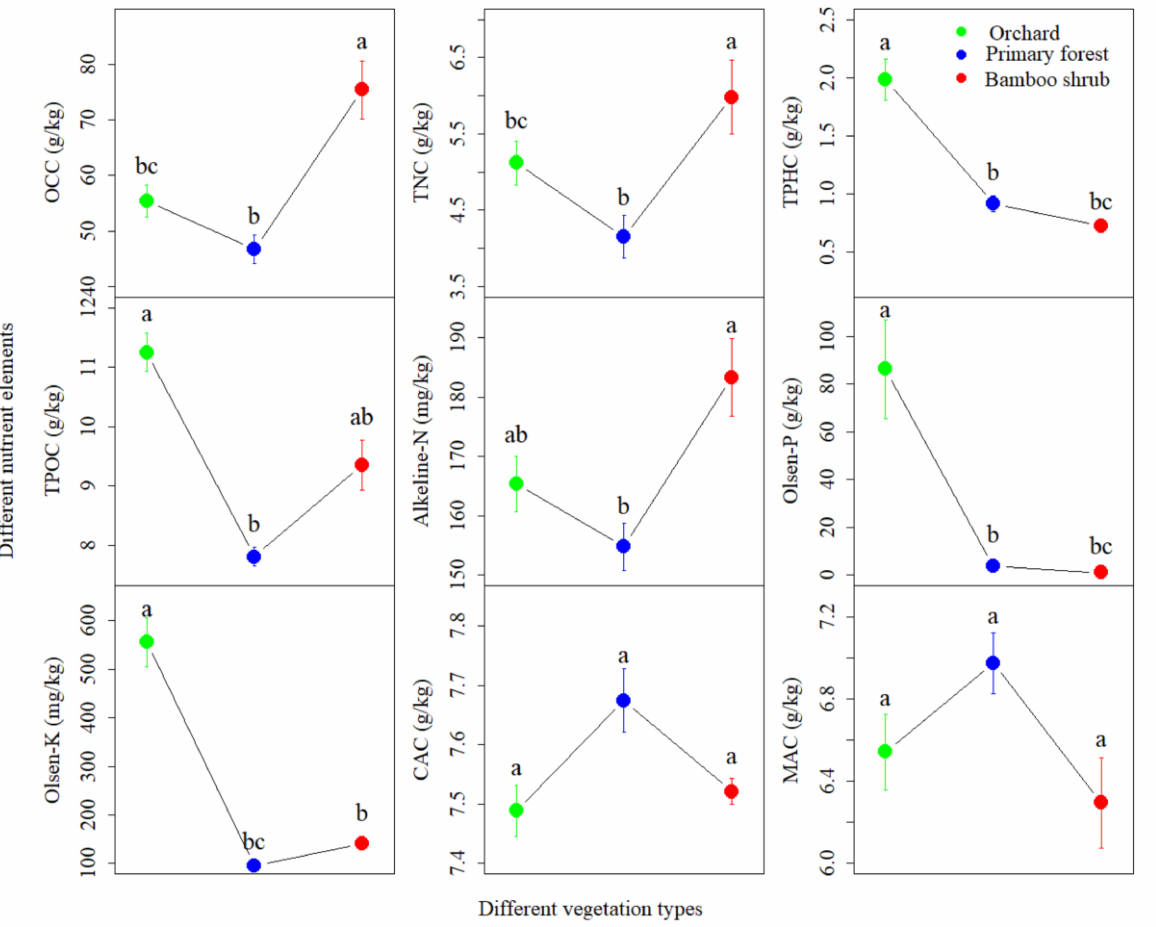
Figure 3. Difference analysis of soil physiochemical properties in each vegetation type (mean ± standard error, n = 15). Different capital letters indicate significant differences (ANOVA, LSD test, p < 0.05). The first two principal components in PCA of the nine variables accounted for 68.63% of the total variation among sites (Table 2). Comp 1 (36.05% of variation) was positively correlated with eight of the nine variables, and negatively with MAC; Comp 2 (32.58% of variation) was highly correlated with eight of the nine variables but had no significant correlation with MAC. In addition, the PCA revealed a separation among different vege- tation types, but with an obvious overlap between the bamboo shrub and primary forest (Figure